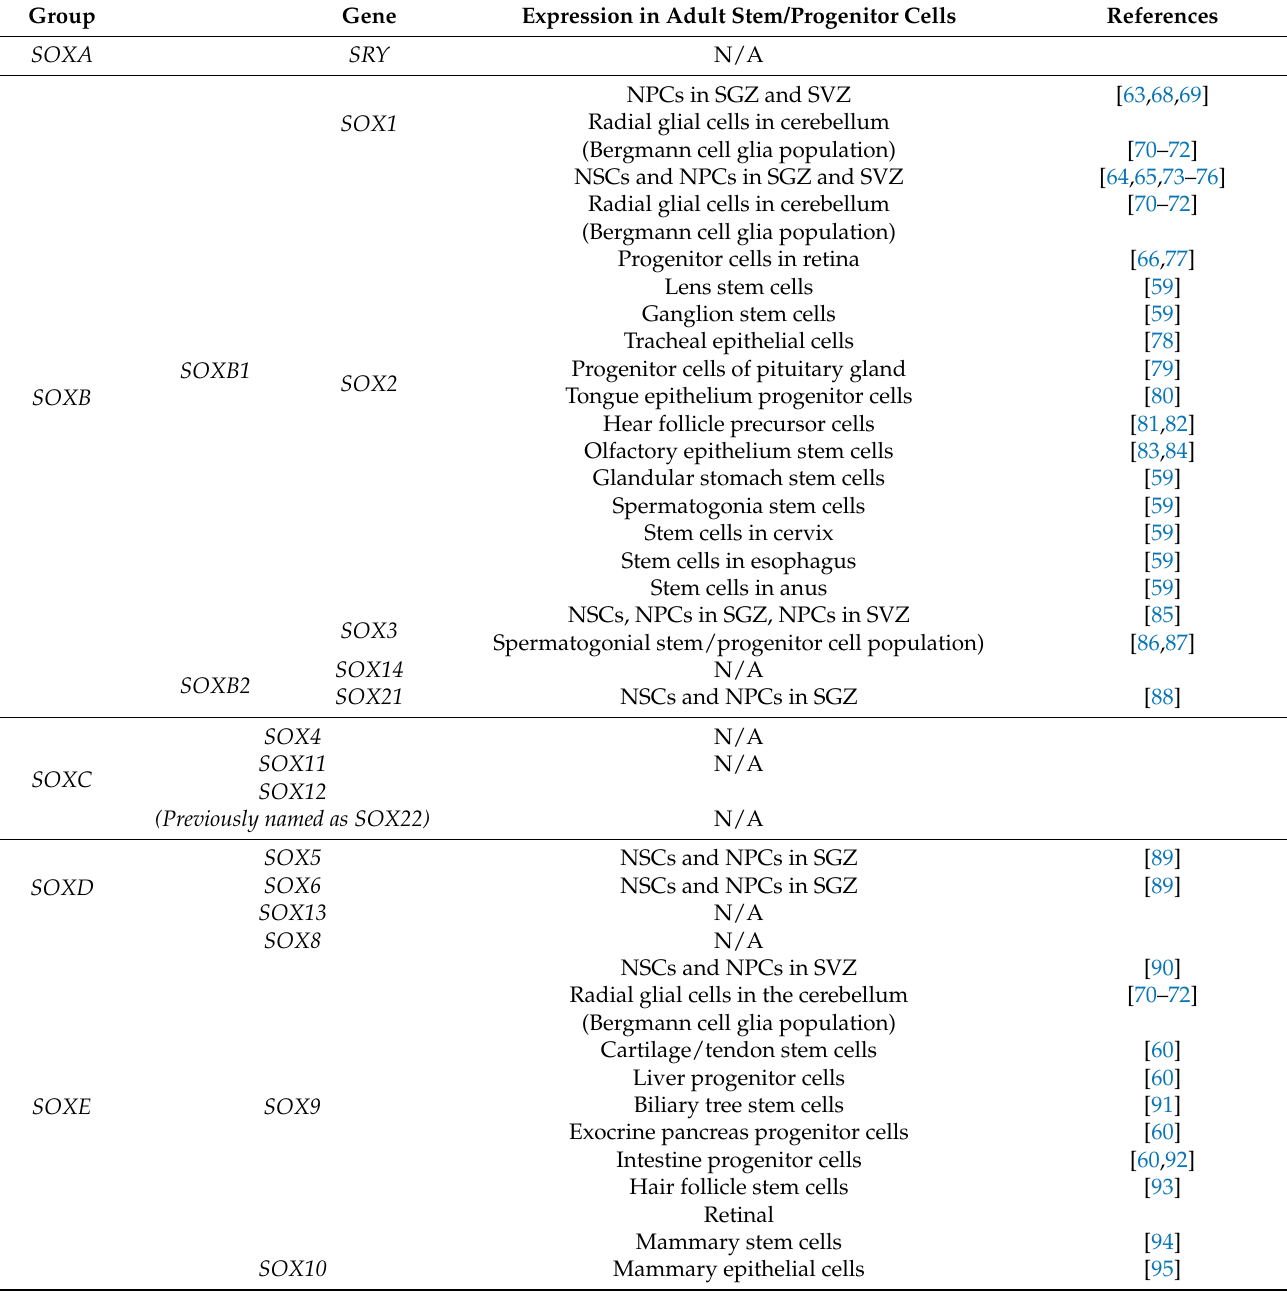
Table 2. SOX genes expression in adult stem/progenitor